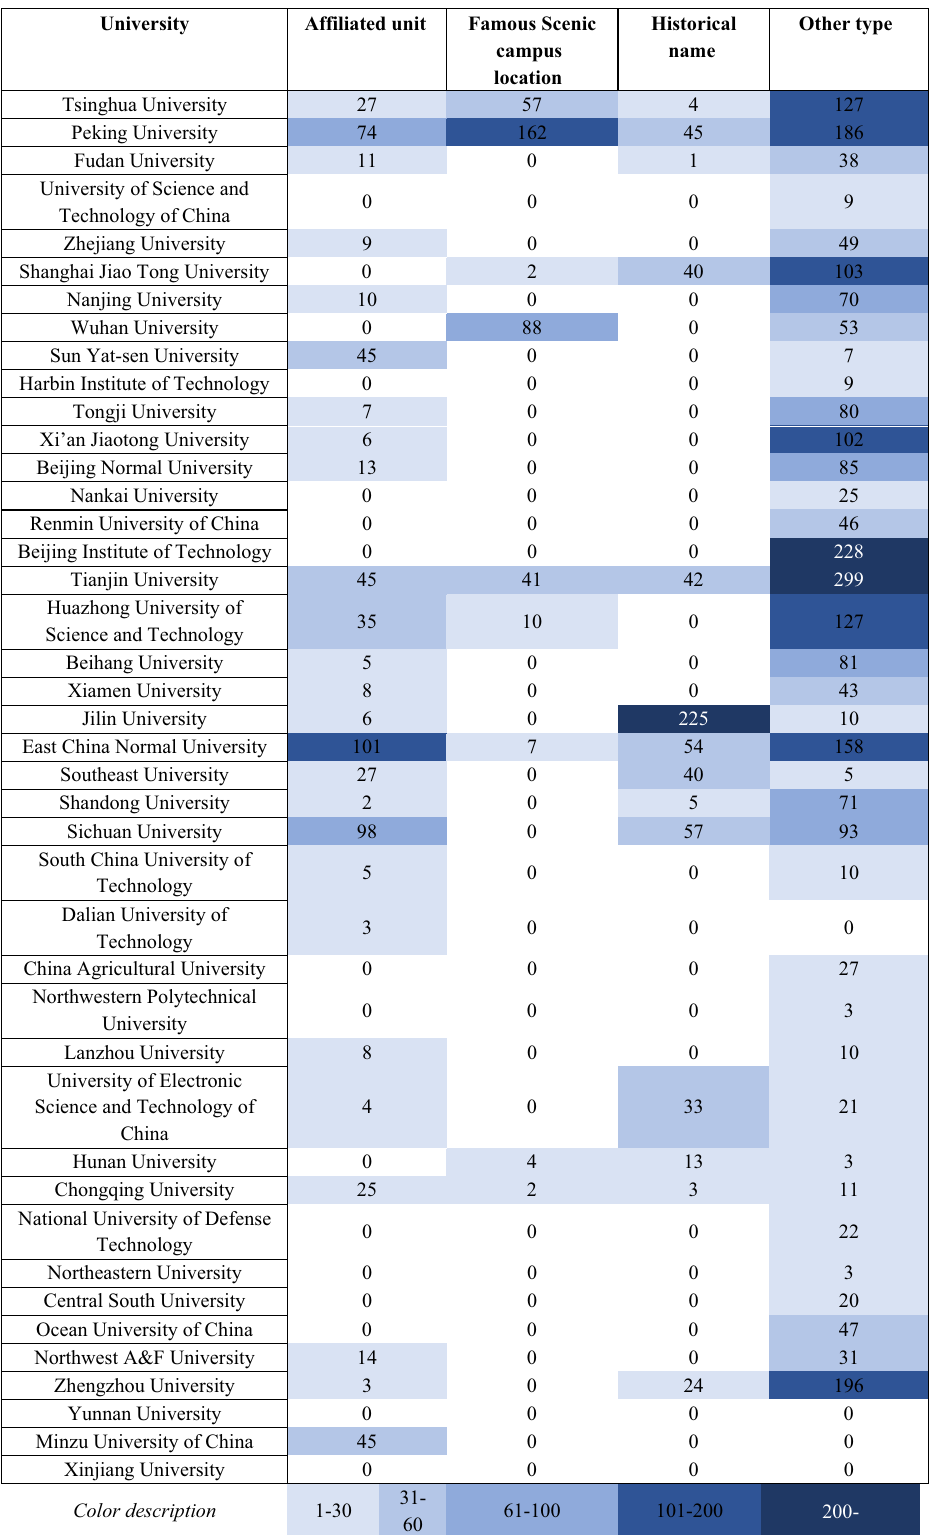
Table 2 Distribution of non-core trademarks for the 42 fi rst-class